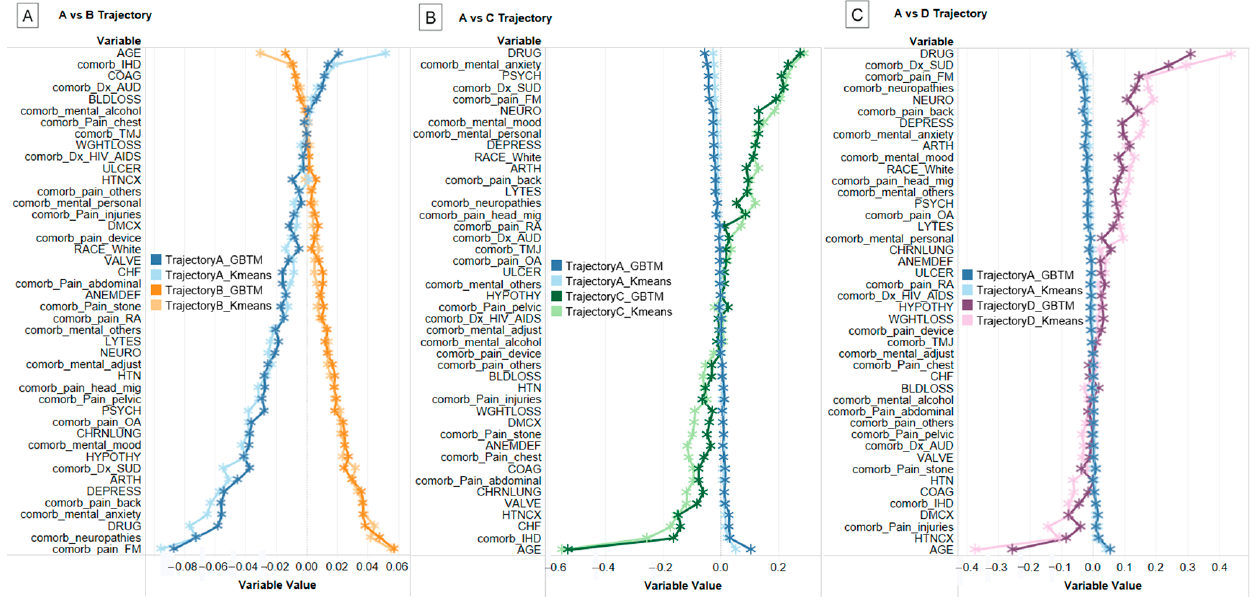
Figure 8. Comparison of va ttriables that contribute to